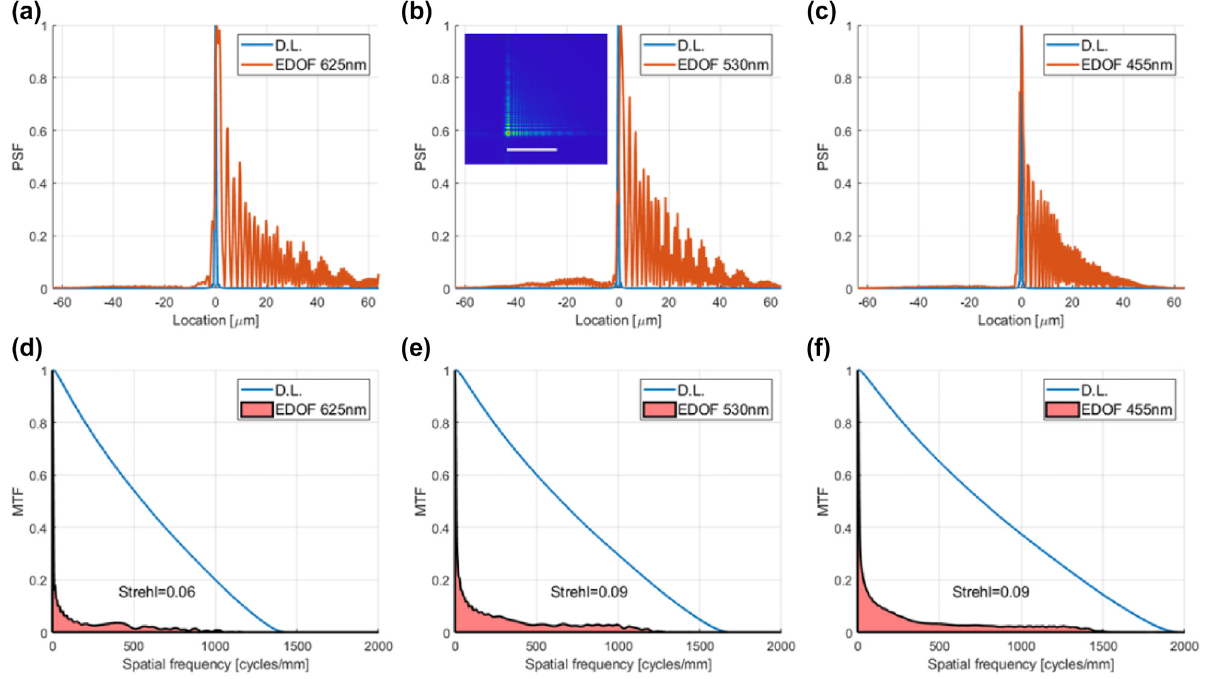
Figure 7: PSFs and MTFs of EDOF lens at wavelengths used in [9]. (a) 625 nm PSF cross section (b) 530 nm PSF cross section. Inset – 2D PSF.